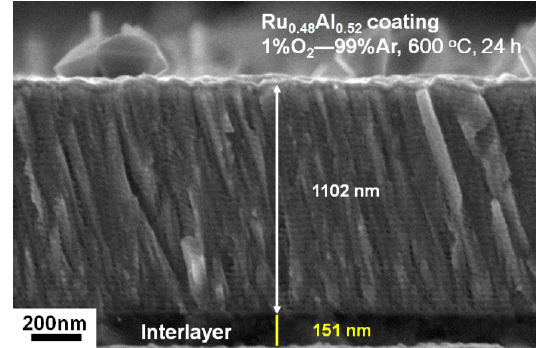
Figure 5. Cross-sectional SEM image of the Ru 0.48 Al 0.52 thin films annealed in 1% O 2 –99% Ar at 600 °C for 24 h.